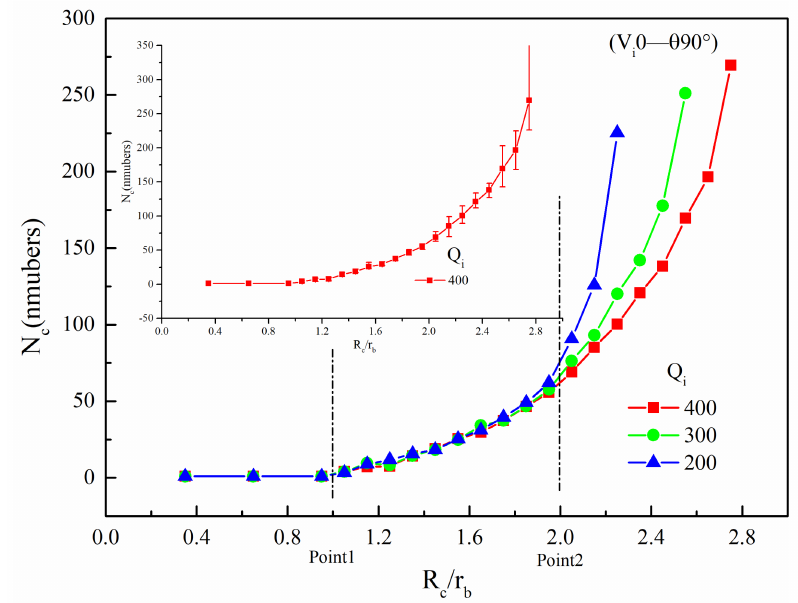
Figure 10. The N c under different R c /r b